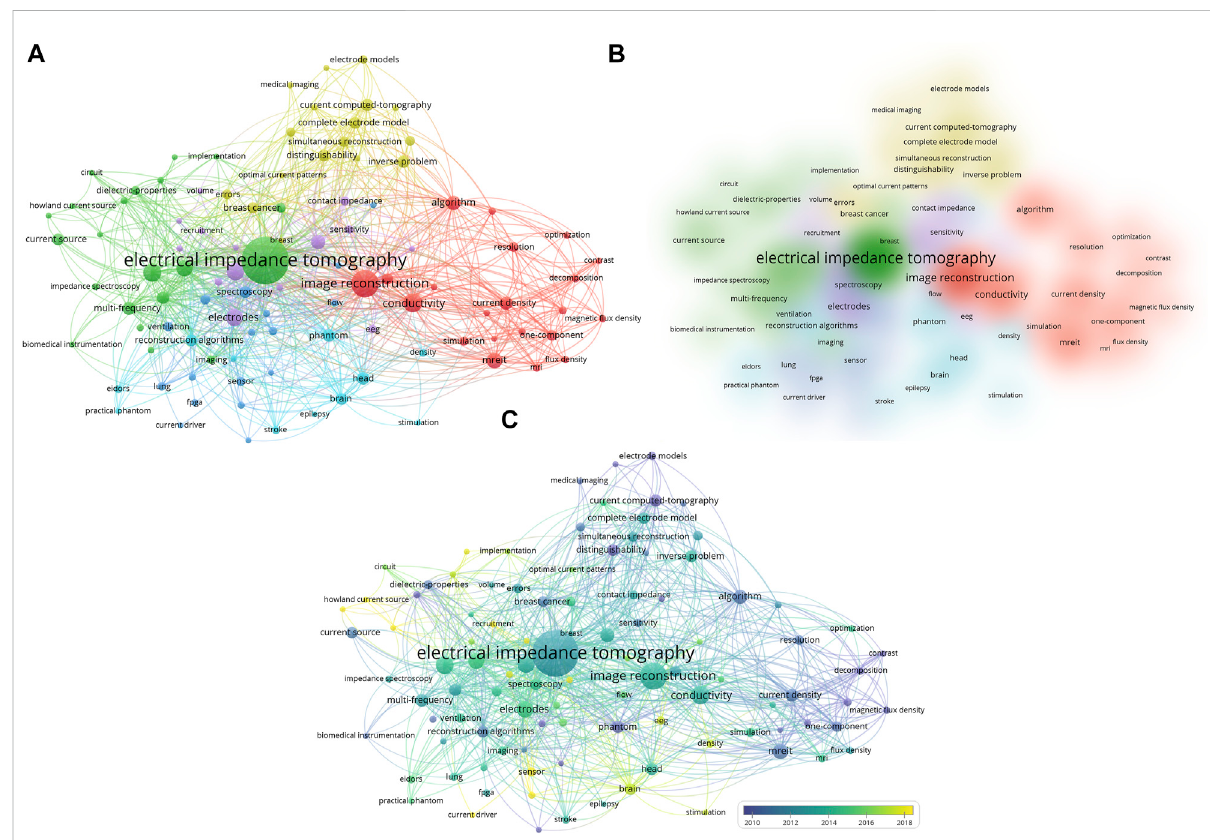
FIGURE 5 Visualization map of keywords co-occurrence network (A,B) and overlay (C) analysis on EIT hardware research from 1989.01.01 to 2021.12.31. The color indicates each cluster (A,B) and the average publication year (C) , due to the limited number of publications before 2010, they share the same color as 2010 (C) . The circle size indicates frequency of co-occurrences (A,C) . The line thickness indicates link strengths (A – C)